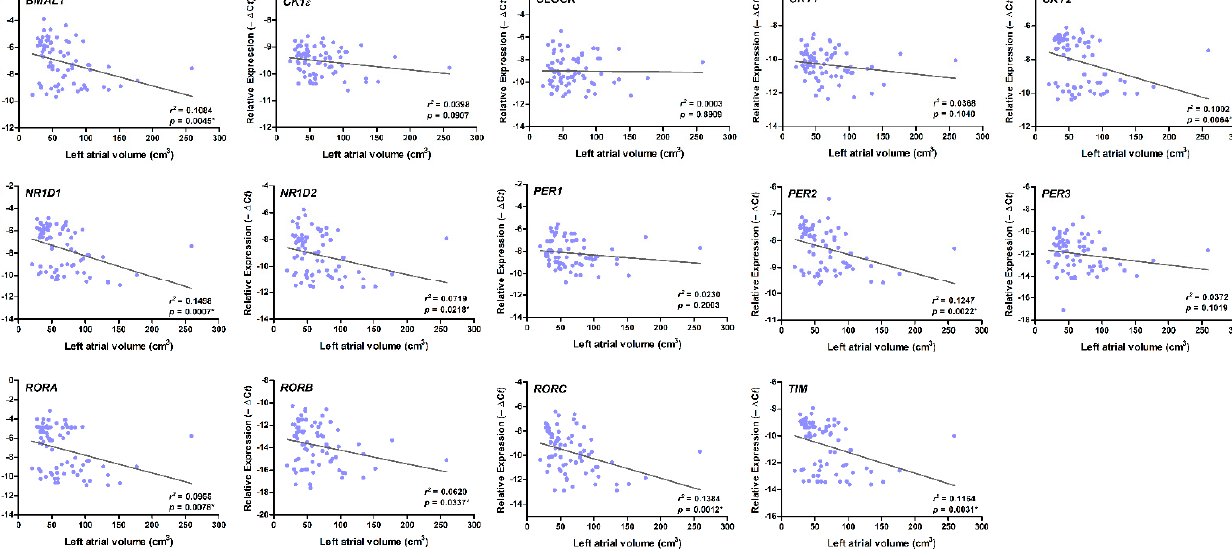
Figure 4. Correlation between the expression of circadian clock genes and left atrial (LA) volume. There was a strong correlation between larger LA diameter and decreased expression of BMAL1 , CRY2 , NR1D1 , NR1D2 , PER2 , RORA , RORB , RORC , and TIM (all p < 0.05), as accessed by bivariate correlation analysis. The r - and p -values indicate the correlation between the expression of circadian clock genes (expressed as −∆ Ct value) and LA volume (expressed as units of cm 3 ).